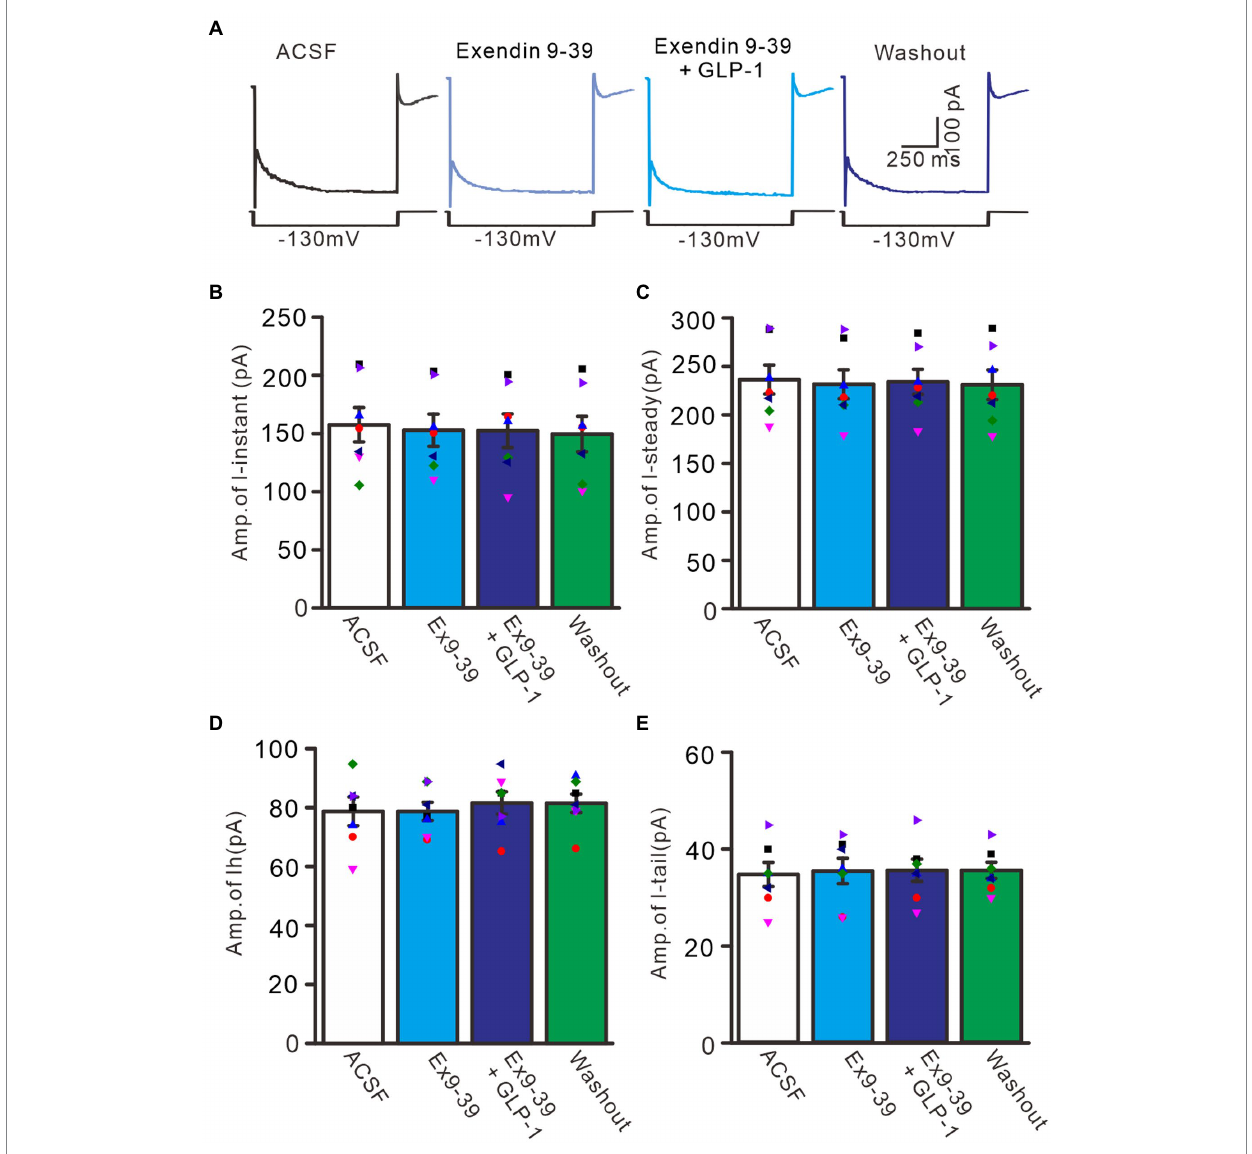
FIGURE 8 Blockade of GLP-1 receptor abolished the effect of GLP-1 on membrane currents in PCs. (A) Under voltage-clamp recording mode (Vh = − 60 mV), the representative traces showing membrane currents elicited by hyperpolarizing voltage steps ( − 130 mV, 1 s) during treatments of ACSF, Exendin 9–39 (100 nM), Exendin9-39+ GLP-1, and washout. (B,C) Bar graphs show the mean (± S.E.M) and individual amplitude of I-instant (I-inst.; B ) and I-steady (C) during each treatment. (D,E) Bar graphs show that the mean (± S.E.M) and individual amplitude of IH (D) and IT (E) during each treatment. n = 7 cells in each